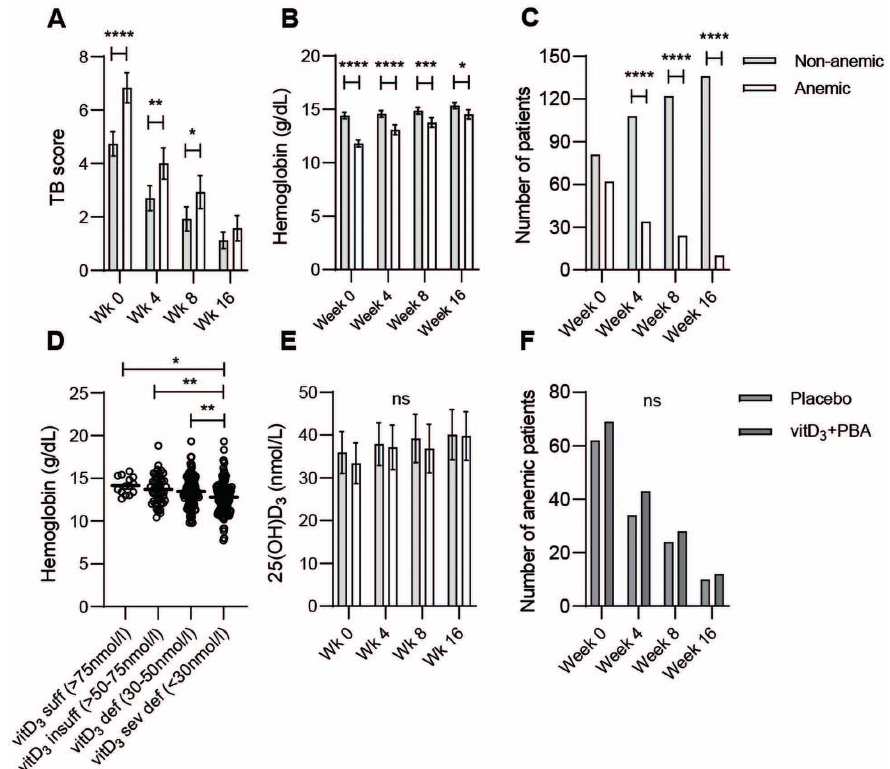
Figure 4. Longitudinal changes in non-anemic (light-grey bars) versus anemic (white bars) TB patients: ( A ) clinical TB score, ( B ) blood Hb levels, ( C ) the numbers of non-anemic and anemic TB patients, ( D ) blood Hb levels in TB patients based on their vitD 3 status at baseline, ( E ) plasma vitD 3 levels, and ( F ) the number of anemic TB patients in the placebo group (grey bars) or in the intervention group (dark-grey bars) at weeks zero (baseline), four, eight, and 16. Data (mean ± 95% CI) from placebo-treated TB patients ( n = 143) are shown in bar graphs and were analyzed using a two-way ANOVA and Sidak ´ s multiple comparisons test, while Hb levels (mean) in TB patients ( n = 345) with sufficient, insufficient, deficient, or severely deficient 25(OH)D 3 levels are shown in the dot plot graph and were analyzed using a one-way ANOVA and Holm–Sidak ´ s multiple comparisons test, p < 0.05 *, p < 0.01 **, p = 0.0001 ***, p < 0.0001 ****, ns = not